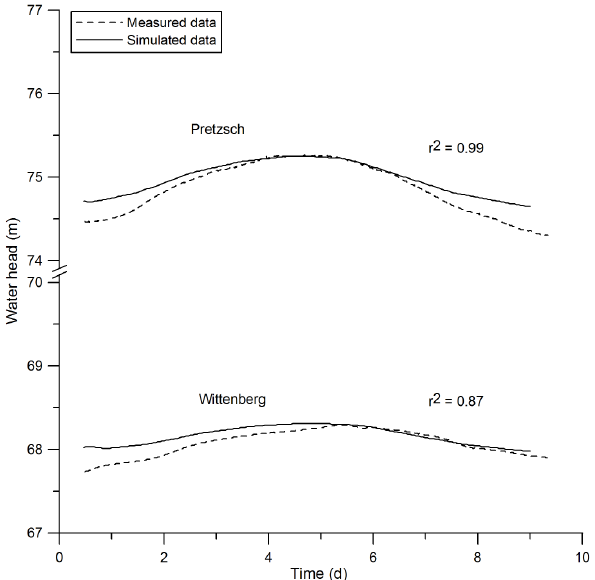
Fig. 9. Simulated and gage recordings of the water level at Pretzsch and Wittenberg during the August 2002 flood